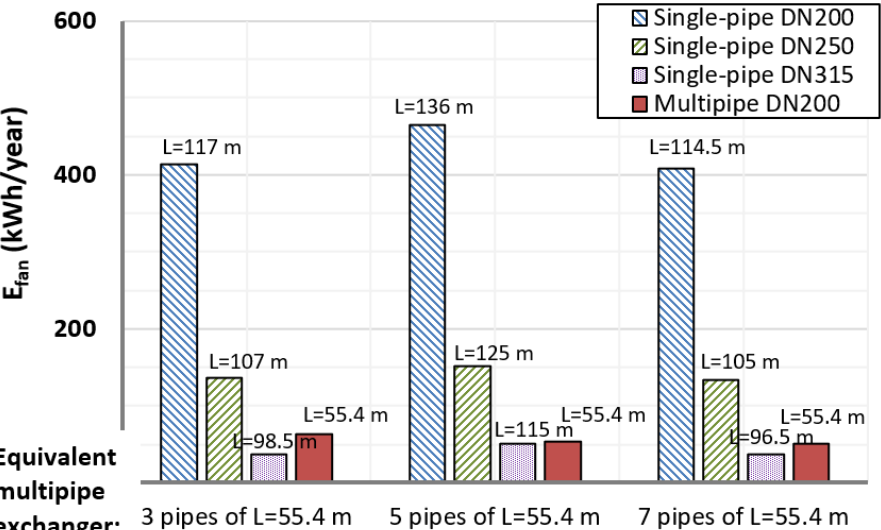
Figure 12. Full-year energy usage for driving the fans for multipipe structures of length L = 55.4 m and single-pipe struc- tures of equivalent length in the context of heating capacity with different pipe diameters: d = DN200, DN250 or DN315, V = 600 m 3 /h.